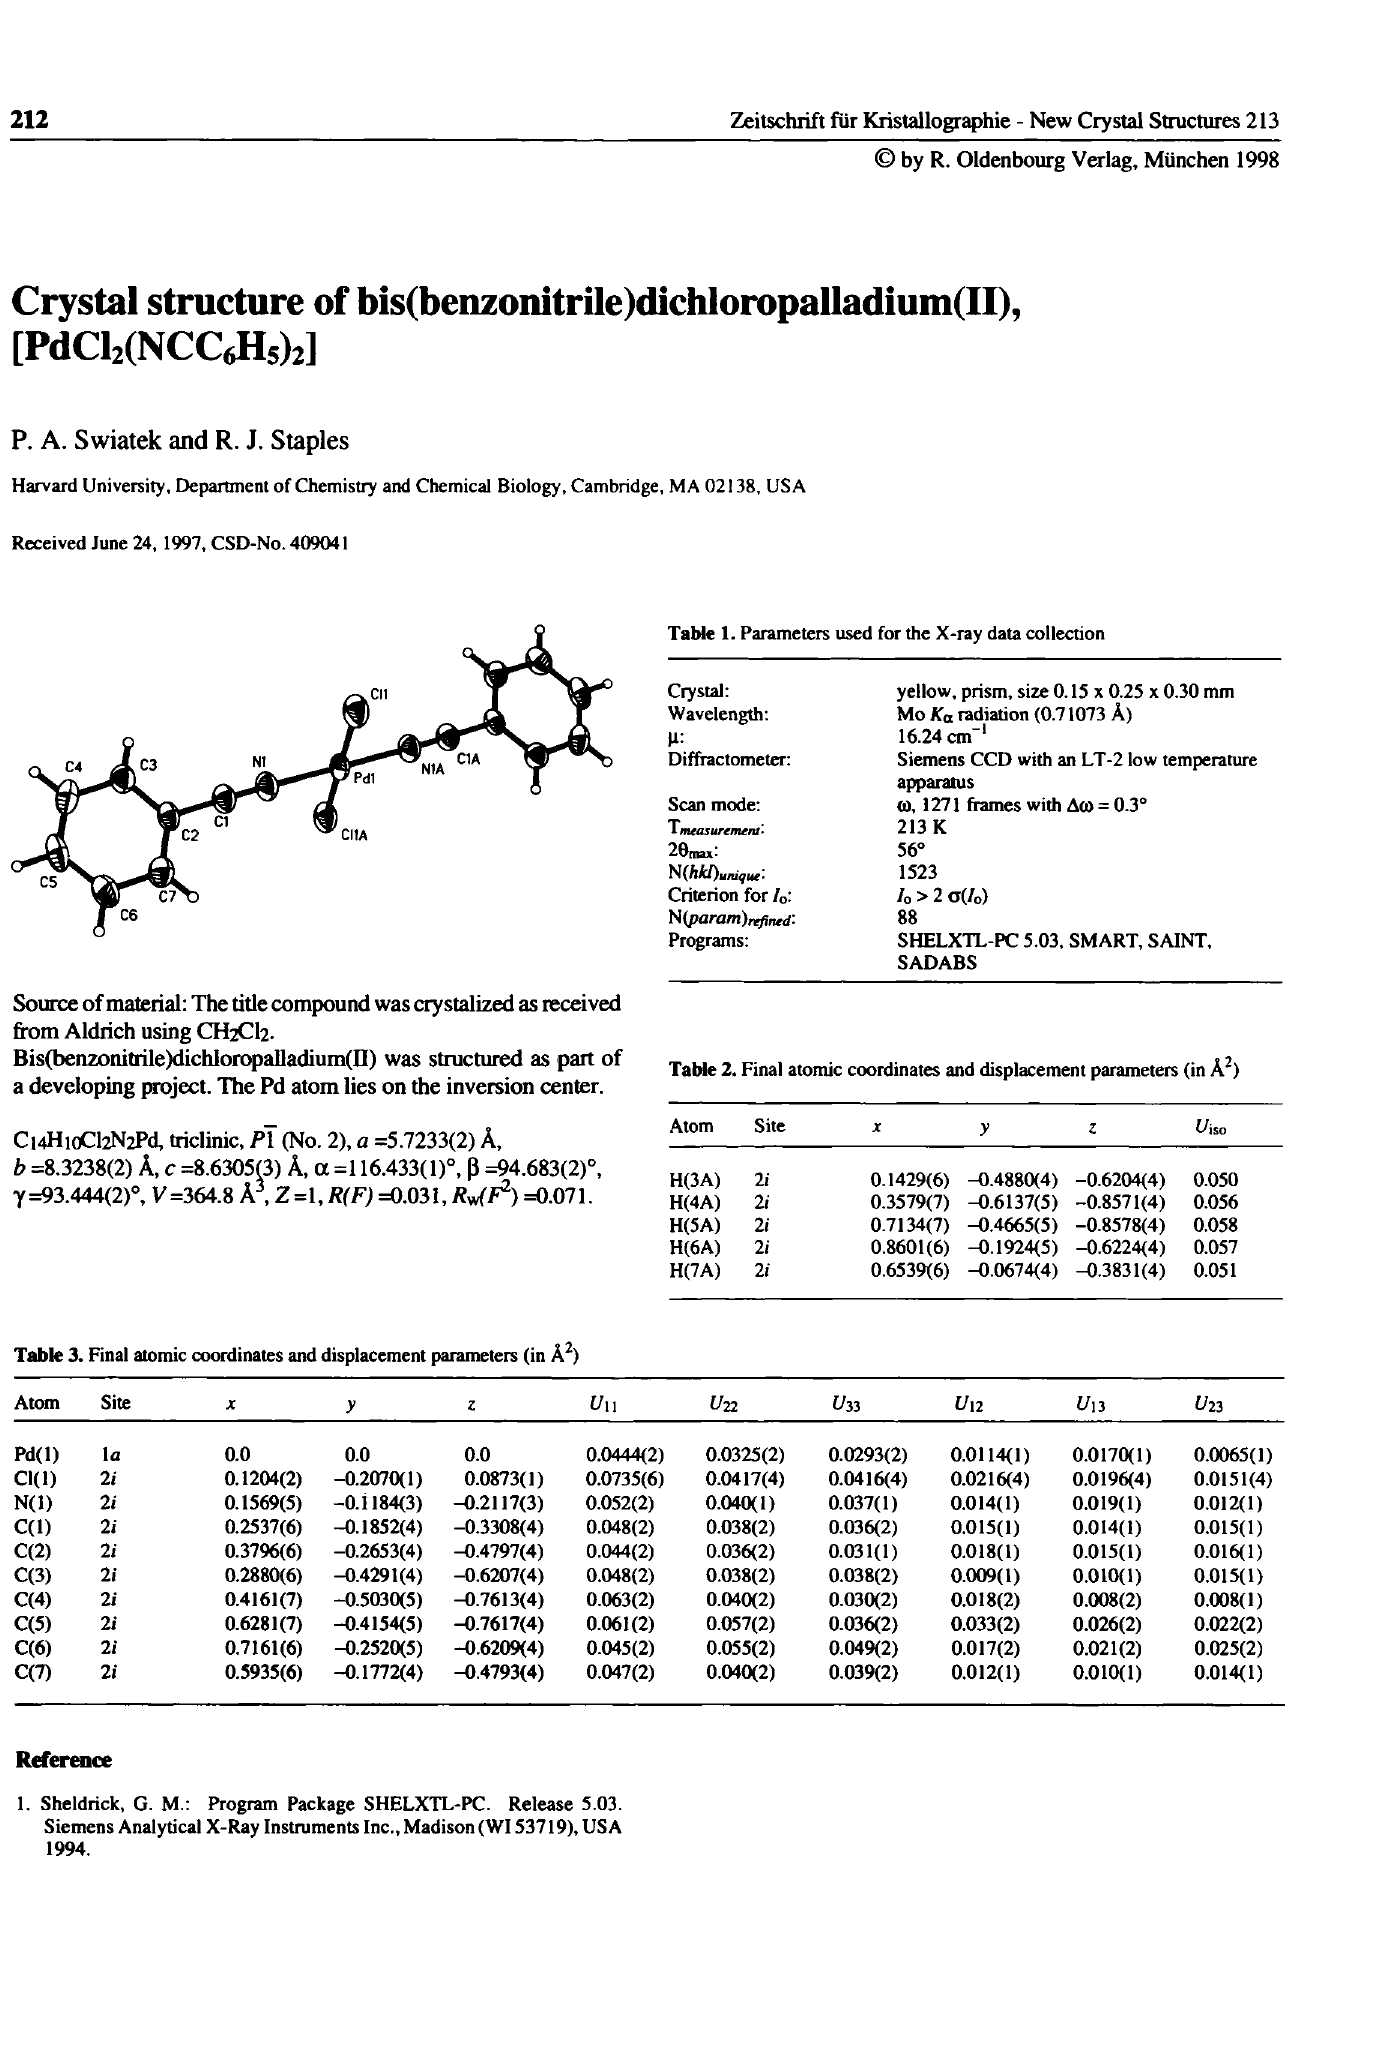
Table 3. Final atomic coordinates and displacement parameters (in